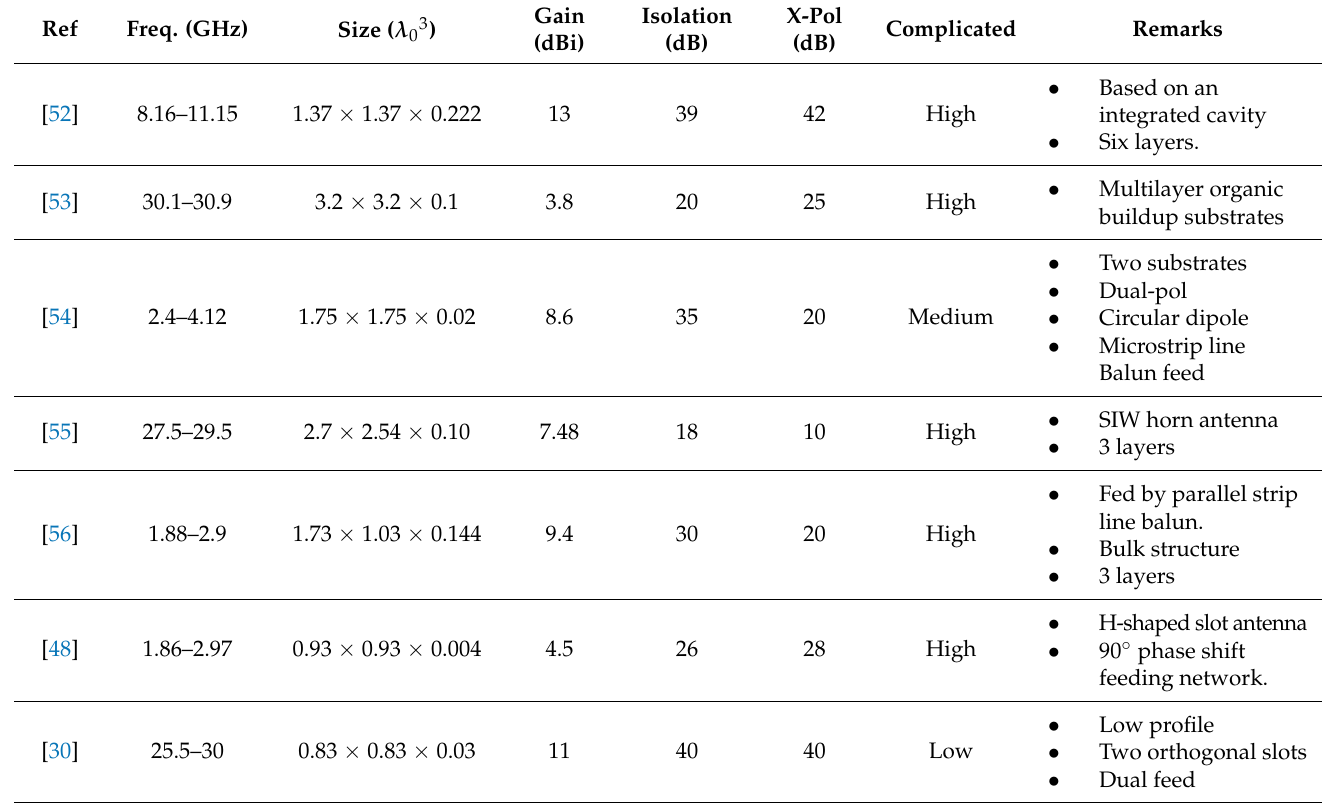
Table 2. Dual-polarized antennas for 5G handheld devices.